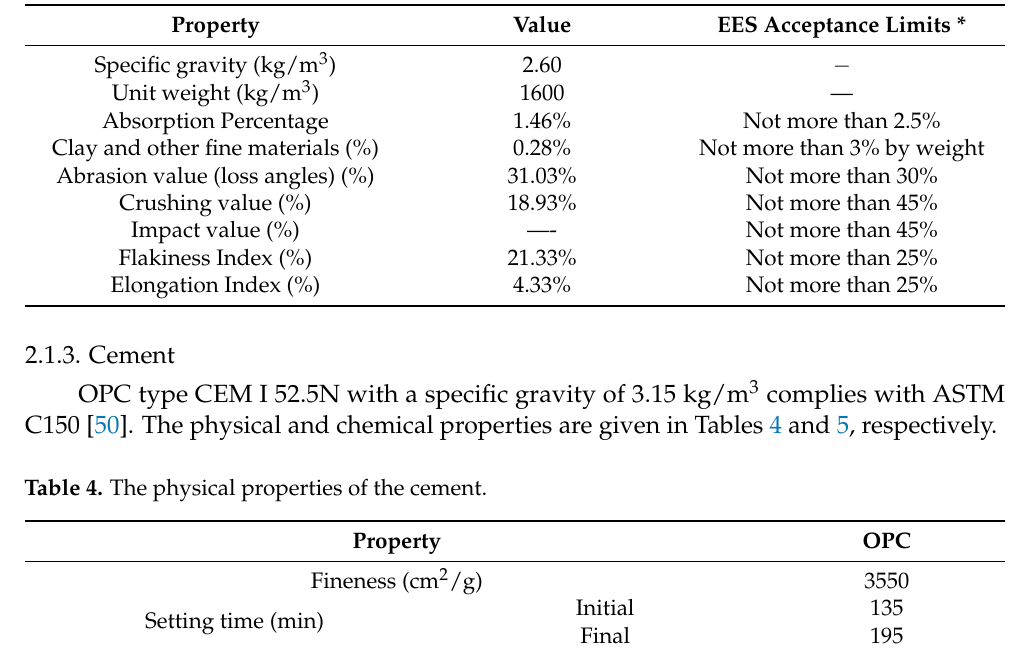
Table 3. The physical and mechanical properties of the coarse aggregate.